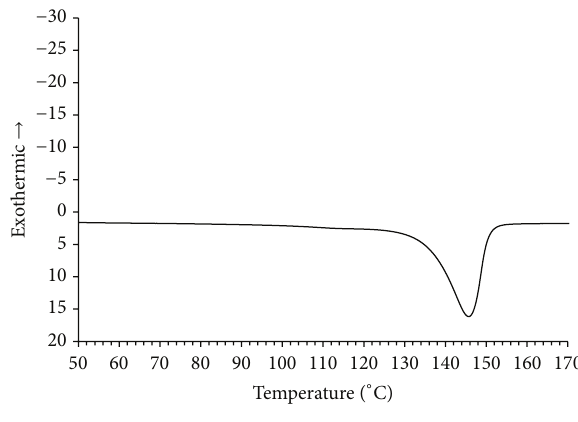
Figure 2: DSC thermograph of UHMWPE powder.